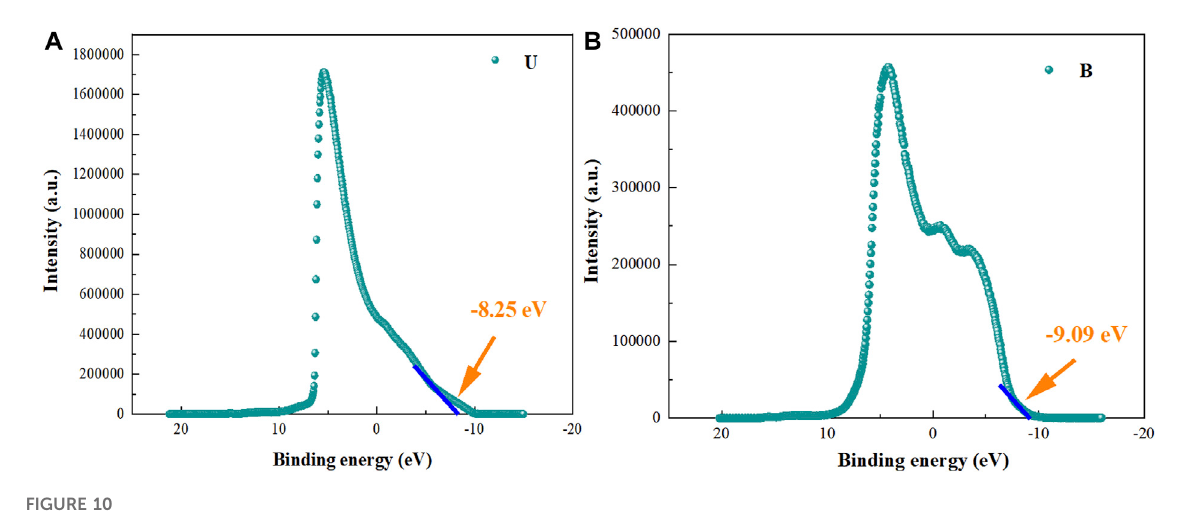
FIGURE 10 The UPS results for U (A) and B (B)